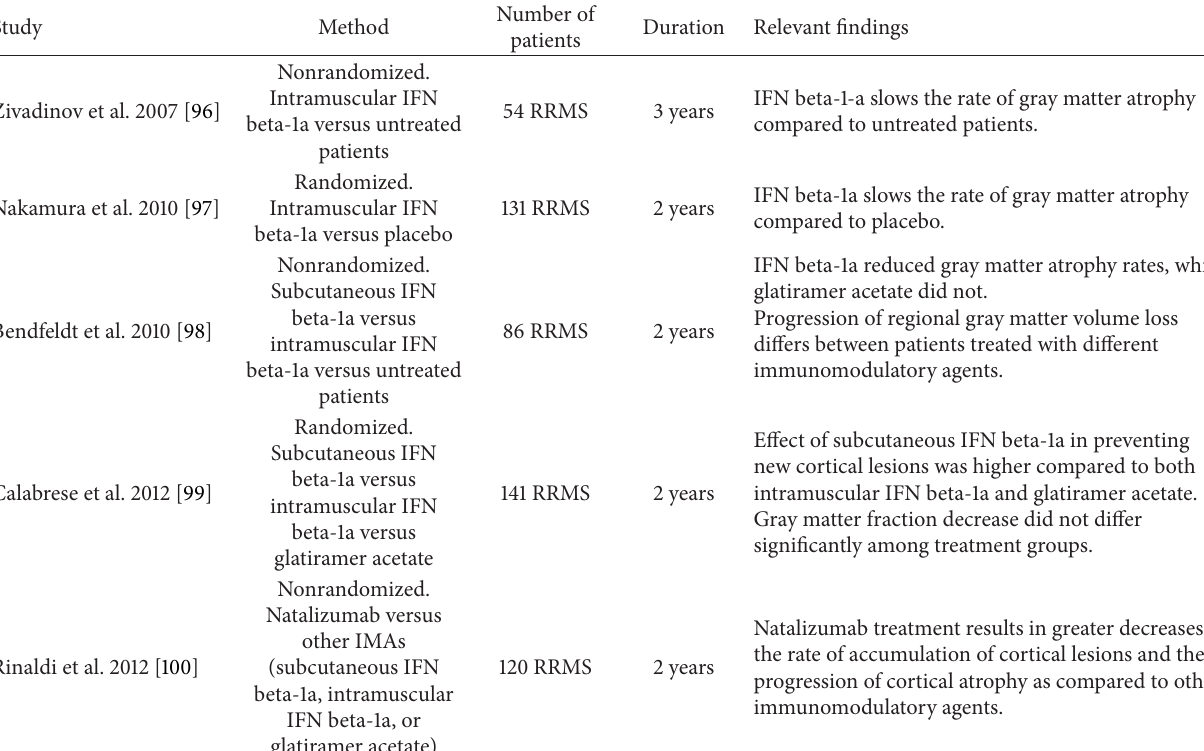
Table 4: Studies demonstrating the effects of disease modifying therapies on measures of gray matter pathology. Number of Study Method Duration Relevant findings patients Nonrandomized. Intramuscular IFN IFN beta-1-a slows the rate of gray matter atrophy Zivadinov et al. 2007 [96] 54 RRMS 3 years beta-1a versus untreated compared to untreated patients